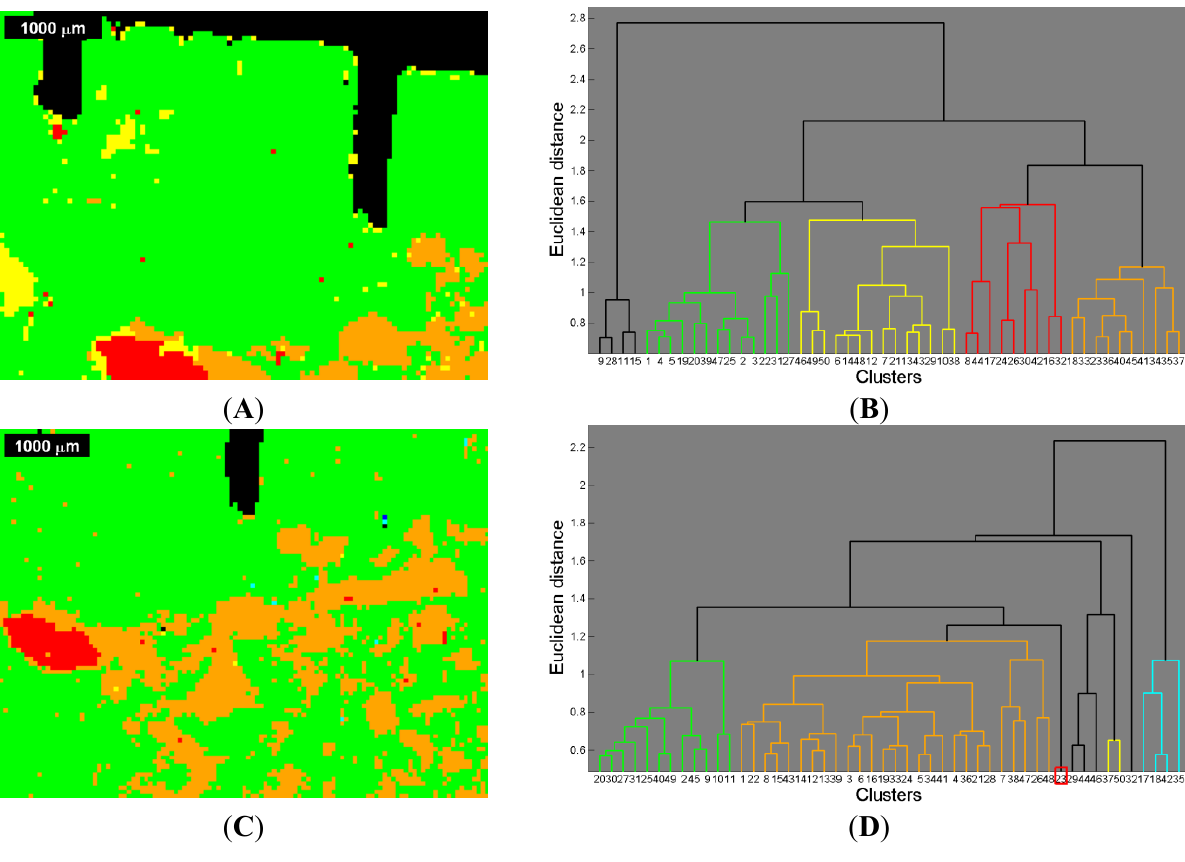
Figure 6. Image segmentation by cluster analysis of the Raman images and